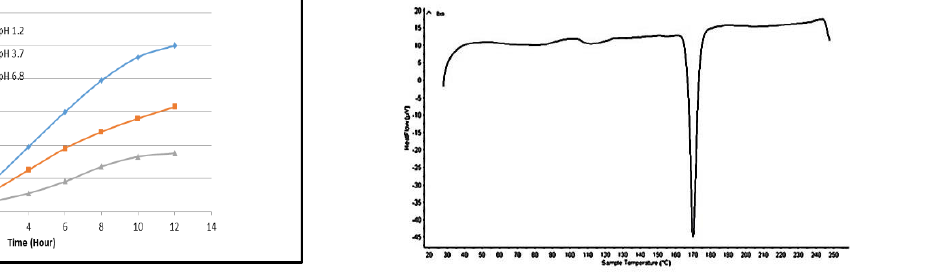
Figure 9. DSC thermogram of pure ITZ at